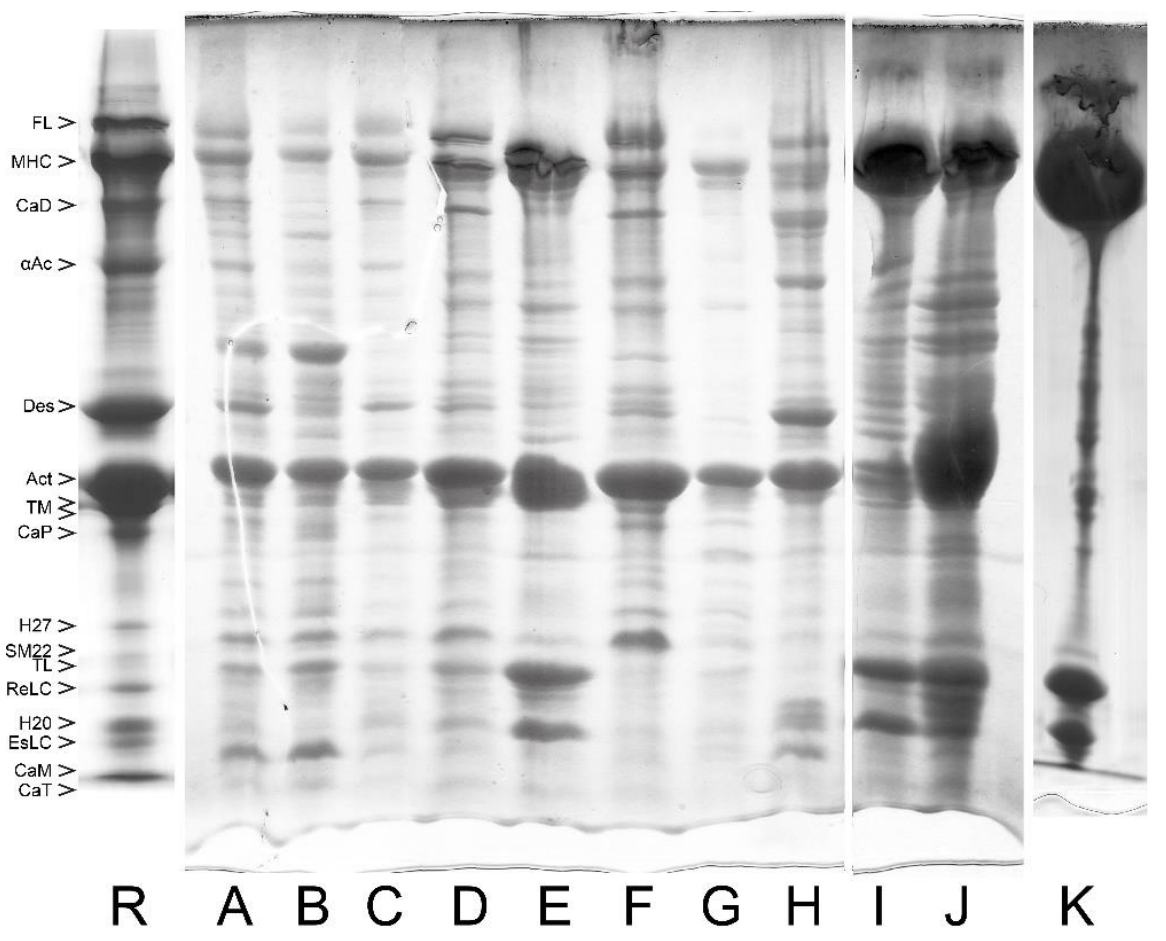
Figure 3. Purification steps of bovine tracheal smooth muscle myosin analyzed by SDS PAGE sys-